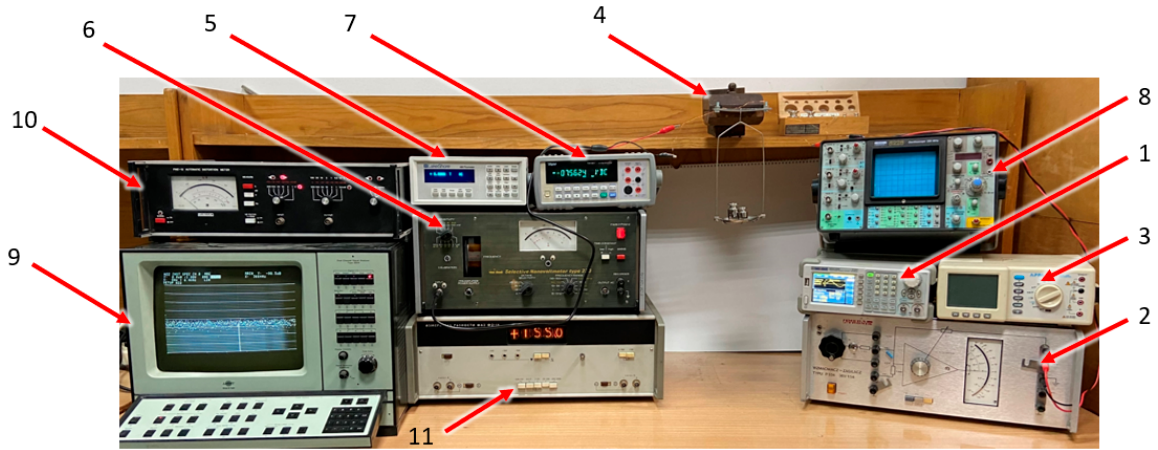
Figure 5. Photo of the test stand with equipment numbered accordingly with the schematic diagram in Figure